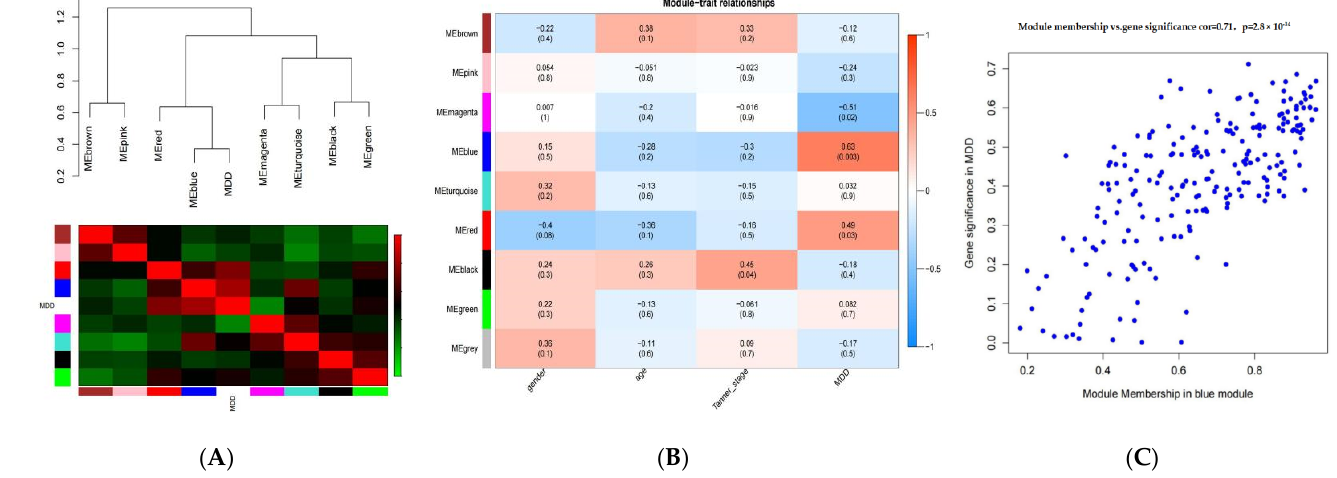
Figure 2. ( A ) The eigengene adjacency heatmap. The dendrogram indicates that the blue module is highly related to MDD. ( B ) Correlation heatmap of modules and traits. The adjusted p -value and correlation coefficient are shown in each cell. ( C ) Scatterplot of Gene significance (GS) for depression VS.module membership (MM) in the blue module. Table 2. Numbers of genes in the eight modules.